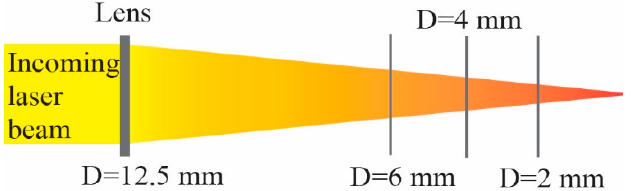
Figure 2. Laser spot size variation by changing the distance between the focus lens and the sample. Table 2. Laser beam power density and energy density at various laser spot sizes.